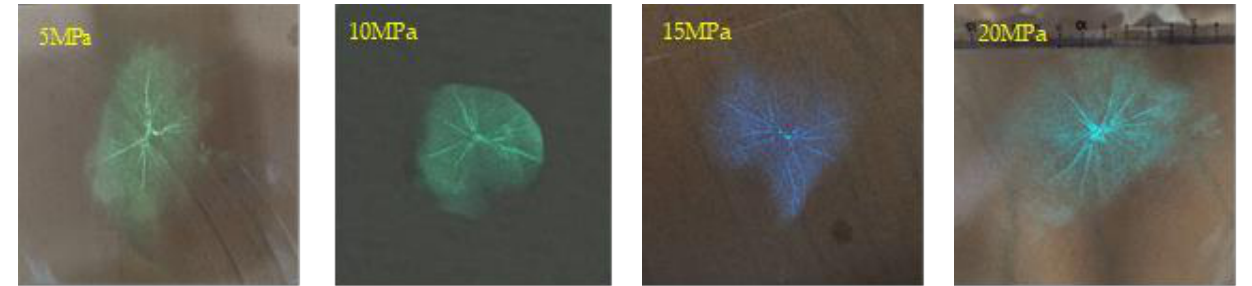
Figure 15. Crack distribution (Group II).